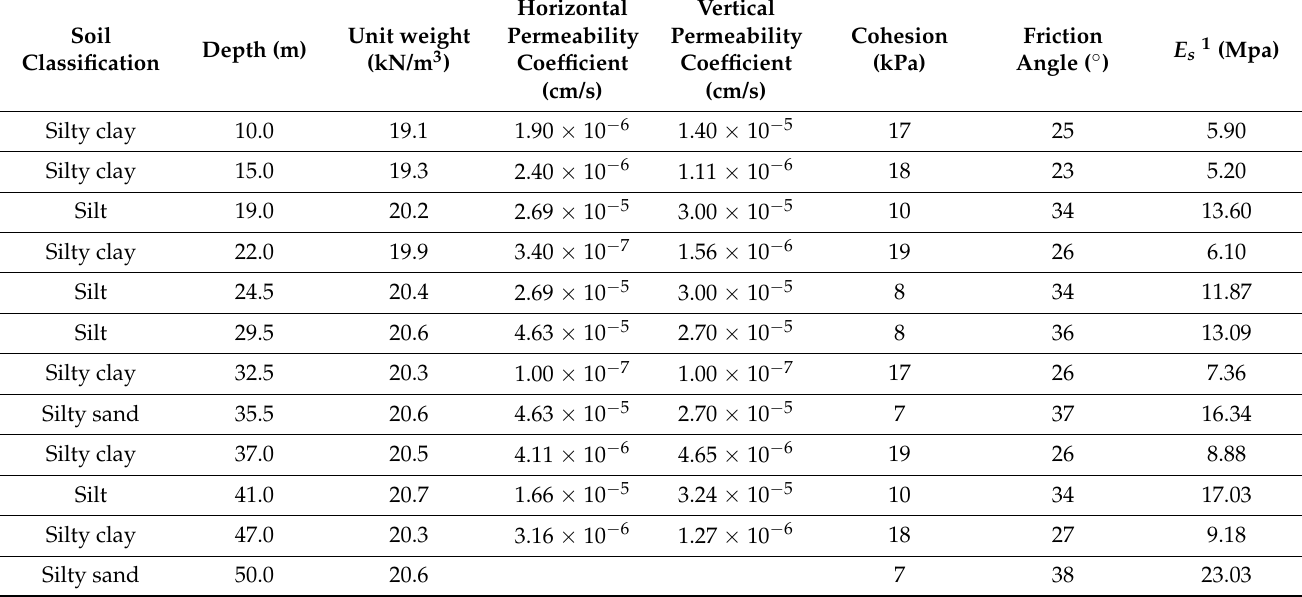
Table 1. Soil layer distribution and